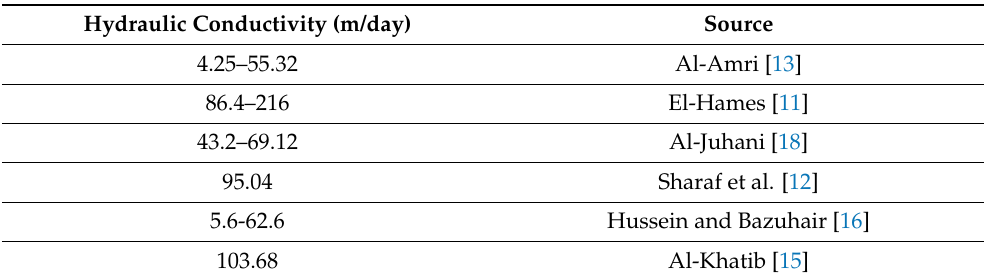
Table 3. Hydraulic conductivity data for the alluvium in Al-Lusub watershed.